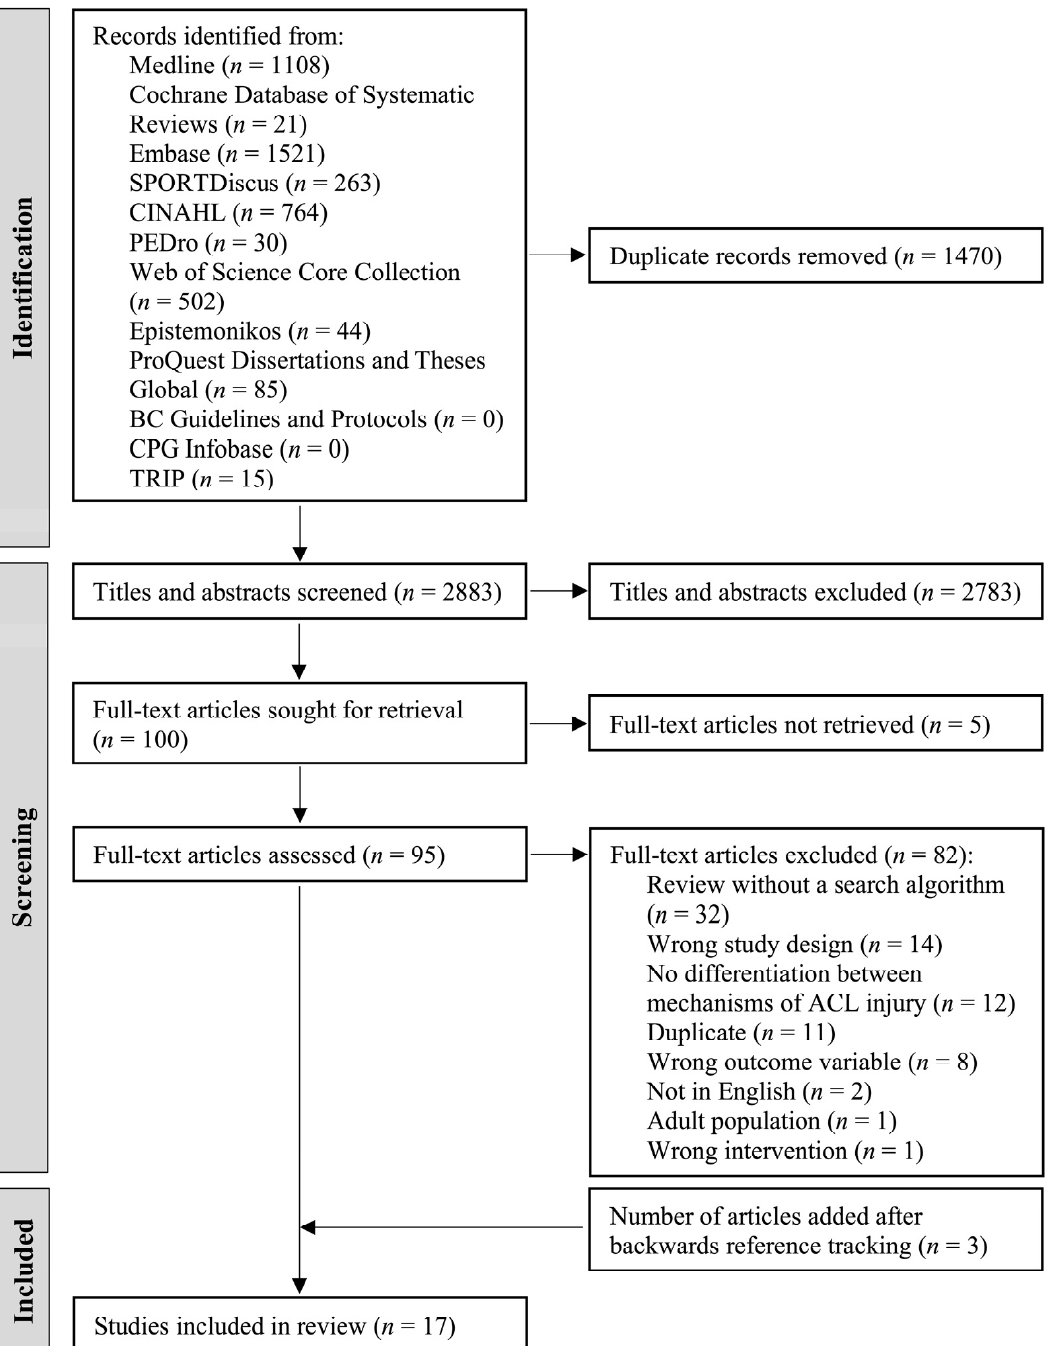
Figure 1. PRISMA flow diagram of the literature search for review articles.